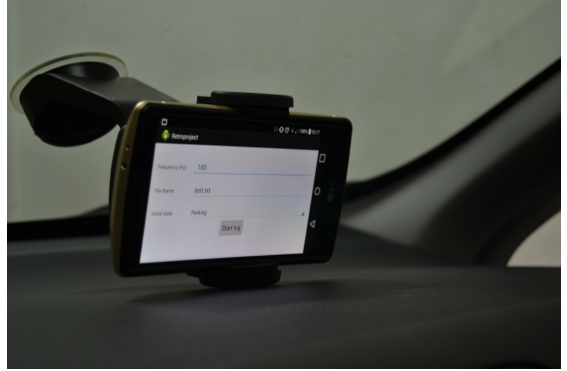
Figure 5. Smartphone installation for the data collection campaign.